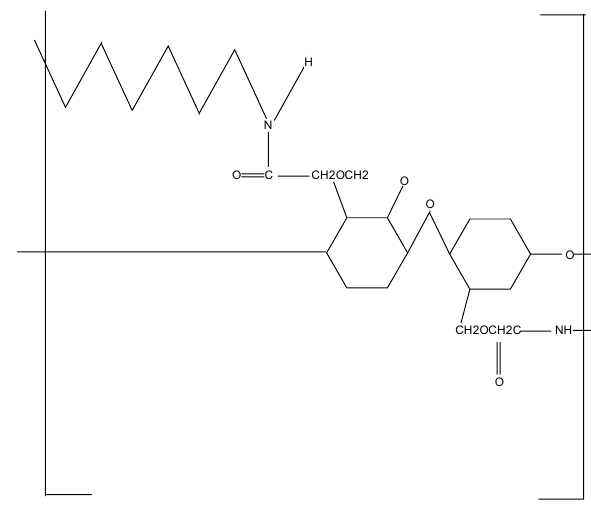
Fig. 4 Scheme of polyamide structure produced from the reaction between 1,6-hexamethylenediamine and